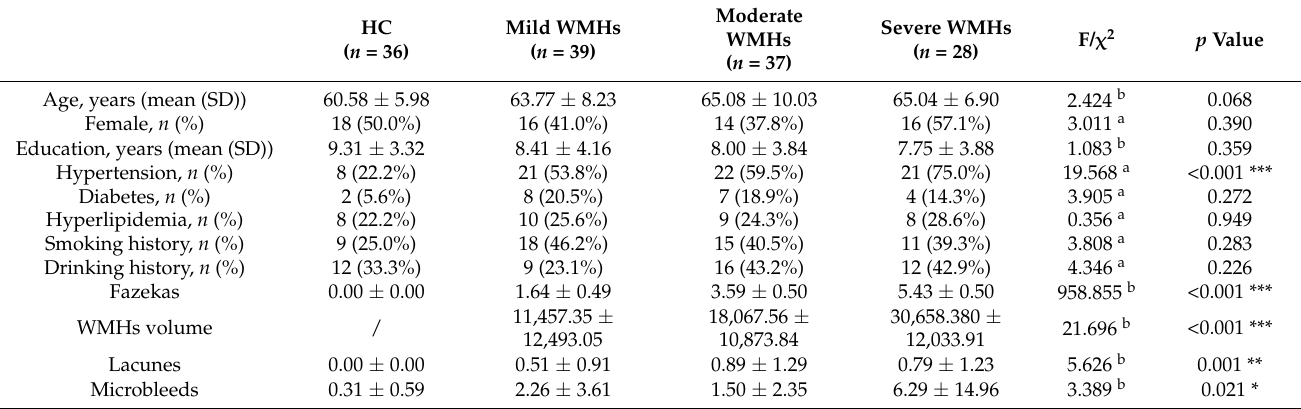
Table 1. Demographic and neuroimaging manifestations.